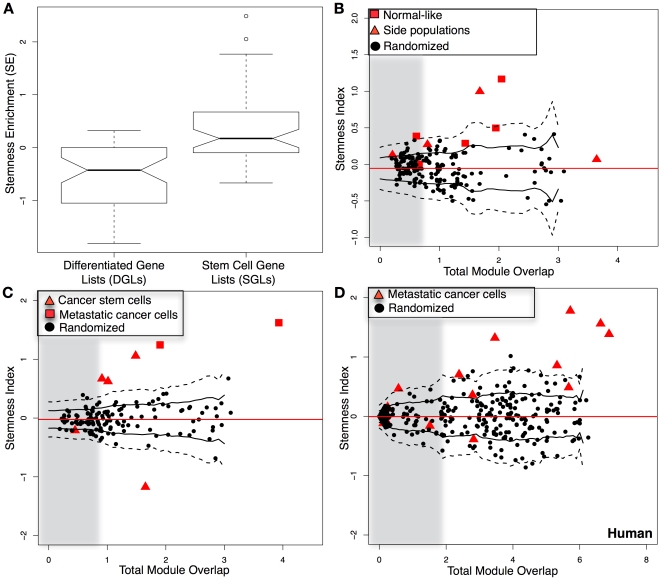
S-MAP modules predict stemness in validation data and in cancer metastases in mouse and human.(A) A Stemness Enrichment score (SE; y-axis) between each experimental set of up-regulated genes – for all DGLs (left boxplot) and all SGLs (right boxplot) – was measured. Positive scores indicate higher overlap with stemness-on compared to stemness-off modules. (B–D) A Stemness Index (SI) was calculated for each experiment as the difference between the Stemness Enrichment scores computed for its up- and down-regulated lists of genes (y-axis) and is plotted against a Total Module Overlap (x-axis). For each query experiment (red squares and red triangles), 20 matched random experiments were simulated to construct a null distribution for both the SI and Total Module Overlap (black circles). Gray regions are drawn to enclose half of the random controls. The mean SI from the null distribution (solid red line) is shown along with one standard deviation (black solid lines) and two standard deviations (black dashed lines) estimated using a windowing approach. Differentially expressed gene lists were scored for (B) mouse normal stem cells and side populations; (C) mouse cancer stem cells and metastatic tumors; and (D) human metastatic cancer cell populations.